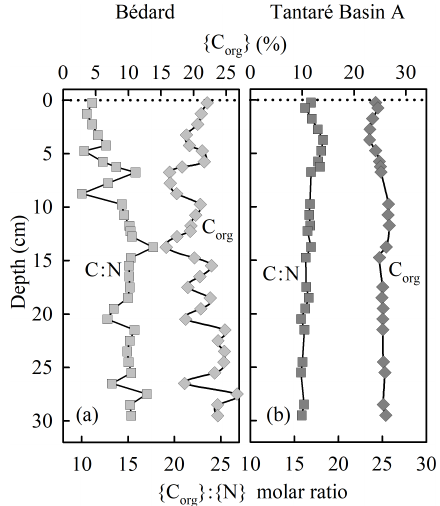
Figure 2. Depth profiles of the organic C concentrations and of the C : N molar ratio in sediment cores collected at the deepest sites of Lake Bédard (a) and Lake Tantaré Basin A (b)